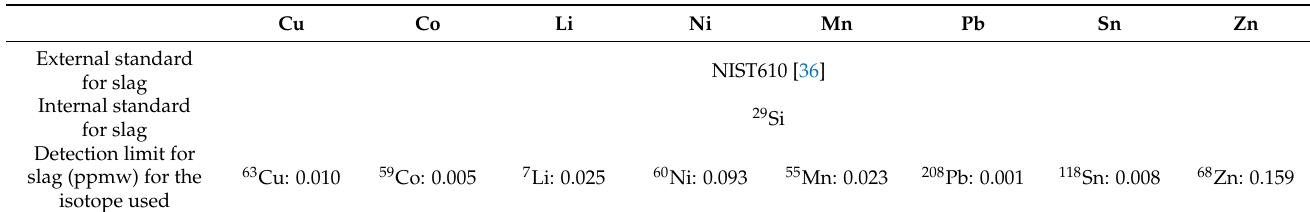
Table 3. Standards used and the detection limits obtained in LA-ICP-MS analysis; ppmw = parts per million by weight. Cu Co